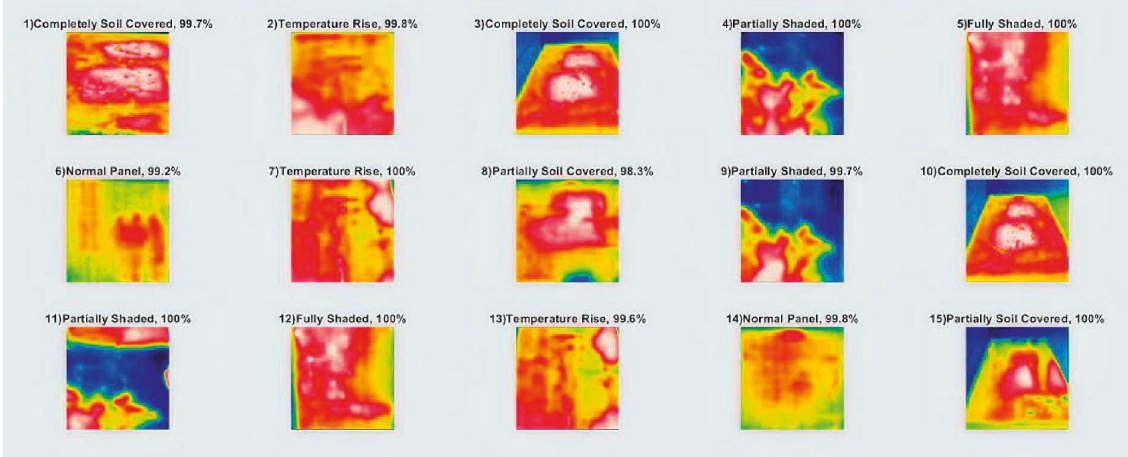
Figure 21: Fault classified by SN for thermal images of solar